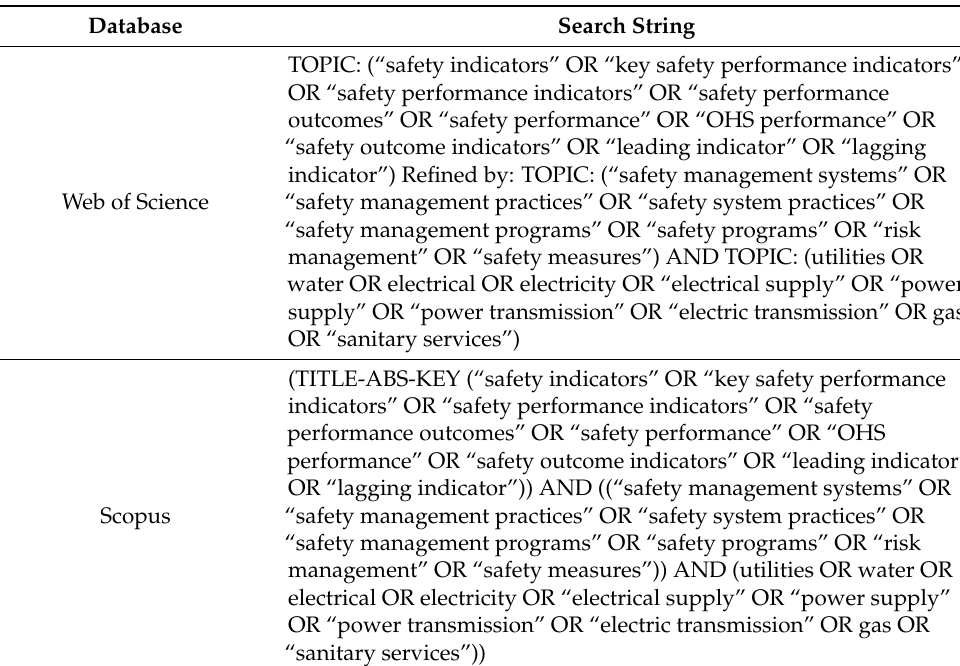
Table 1. The search strings.